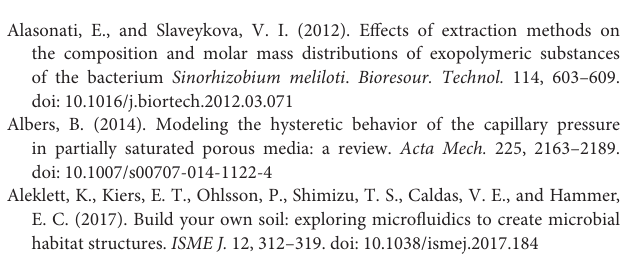
Table S1 | Summary of the experiments and experimental systems described in this report. Videos V1–V6 | Air infiltration into individual emulated soil micromodel channels initially saturated with dilute extracellular polymeric substance (EPS) solutions suspended in M9